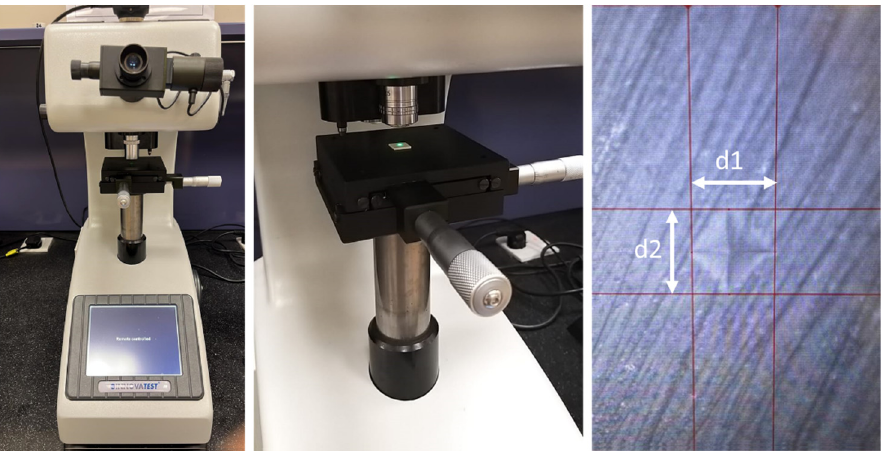
Figure 2. The microhardness testing device used in the study (on the left). The picture in the middle shows more closely the sample positioning table with a ceramic sample in place. The picture on the right side shows Vickers indentation of IPS e.max CAD before bleaching at 20× magnification. The edges of both diagonals are marked to determine their length followed by automatic calculation of the Vickers microhardness number according to the formula: Vickers microhardness number = 1.854 F/d 2 , where F is the applied load in kgf and d is the average diagonal length of the indentation measured in mm [24].